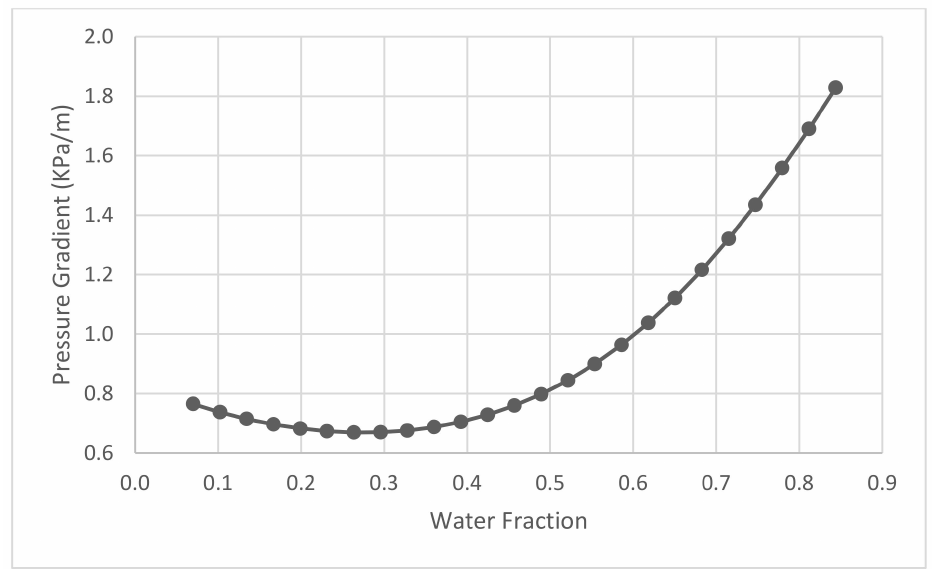
Figure 13. Effect of water fraction.